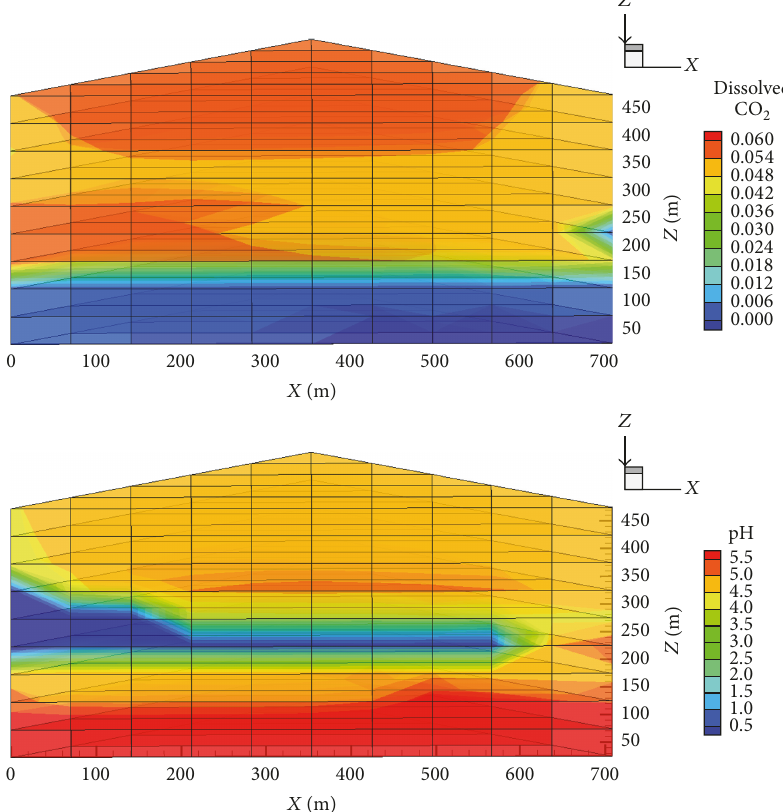
Figure 4: Simulated 3D profiles of dissolved CO 2 mass fraction in aqueous phase and pH values after 30-year injection of scCO 2 as a working